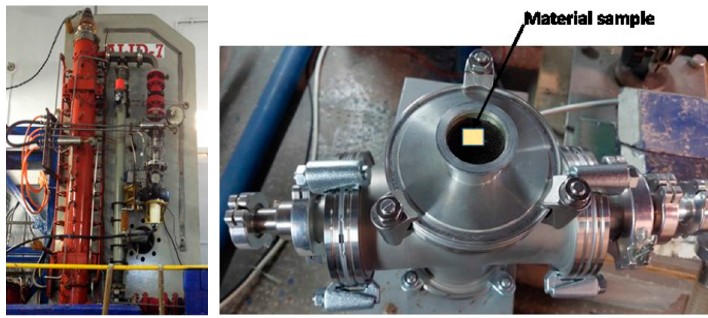
Figure 2. ALID-7 electron beam accelerator ( left ) and the sample chamber ( right ). The materials were irradiated with a beam fluency of 1 × 10 12 e − /cm 2 per pulse, and the corresponding charge per electron beam pulse was 8.8 × 10 − 7 C. The peak beam